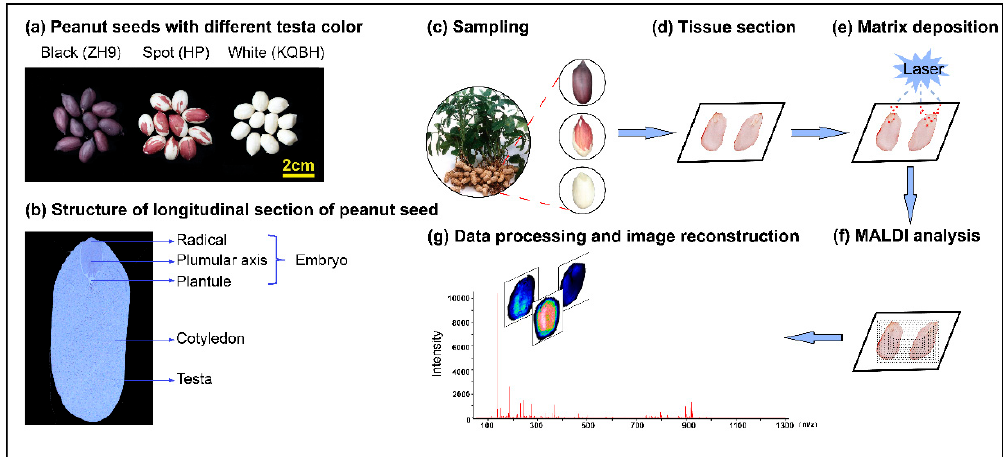
Figure 1. The matrix-assisted laser desorption/ionization MSI (MALDI-MSI) analysis of peanut seeds with different testa color. ( a ) Three peanut cultivars with different testa color (black, spot, and white), ( b ) structure of longitudinal section of peanut seed, and ( c – g ) experimental procedure of MALDI-MSI for peanut seeds.